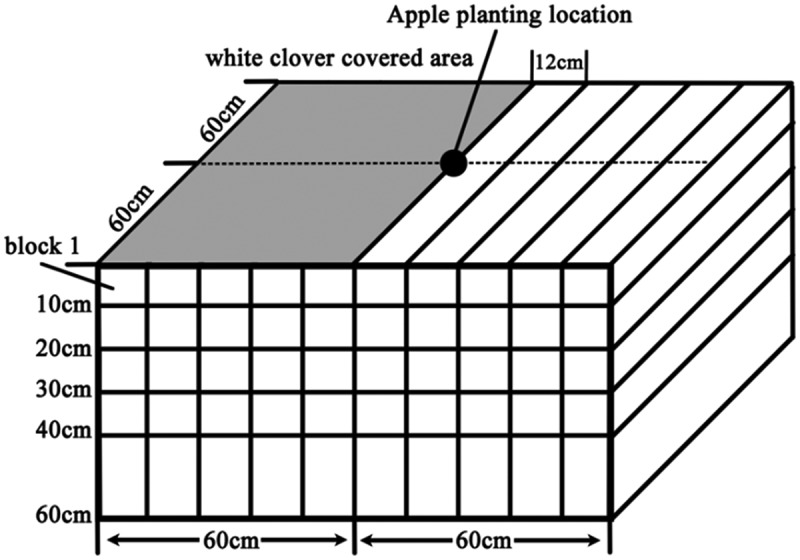
Schematic diagram of apple root sampling.